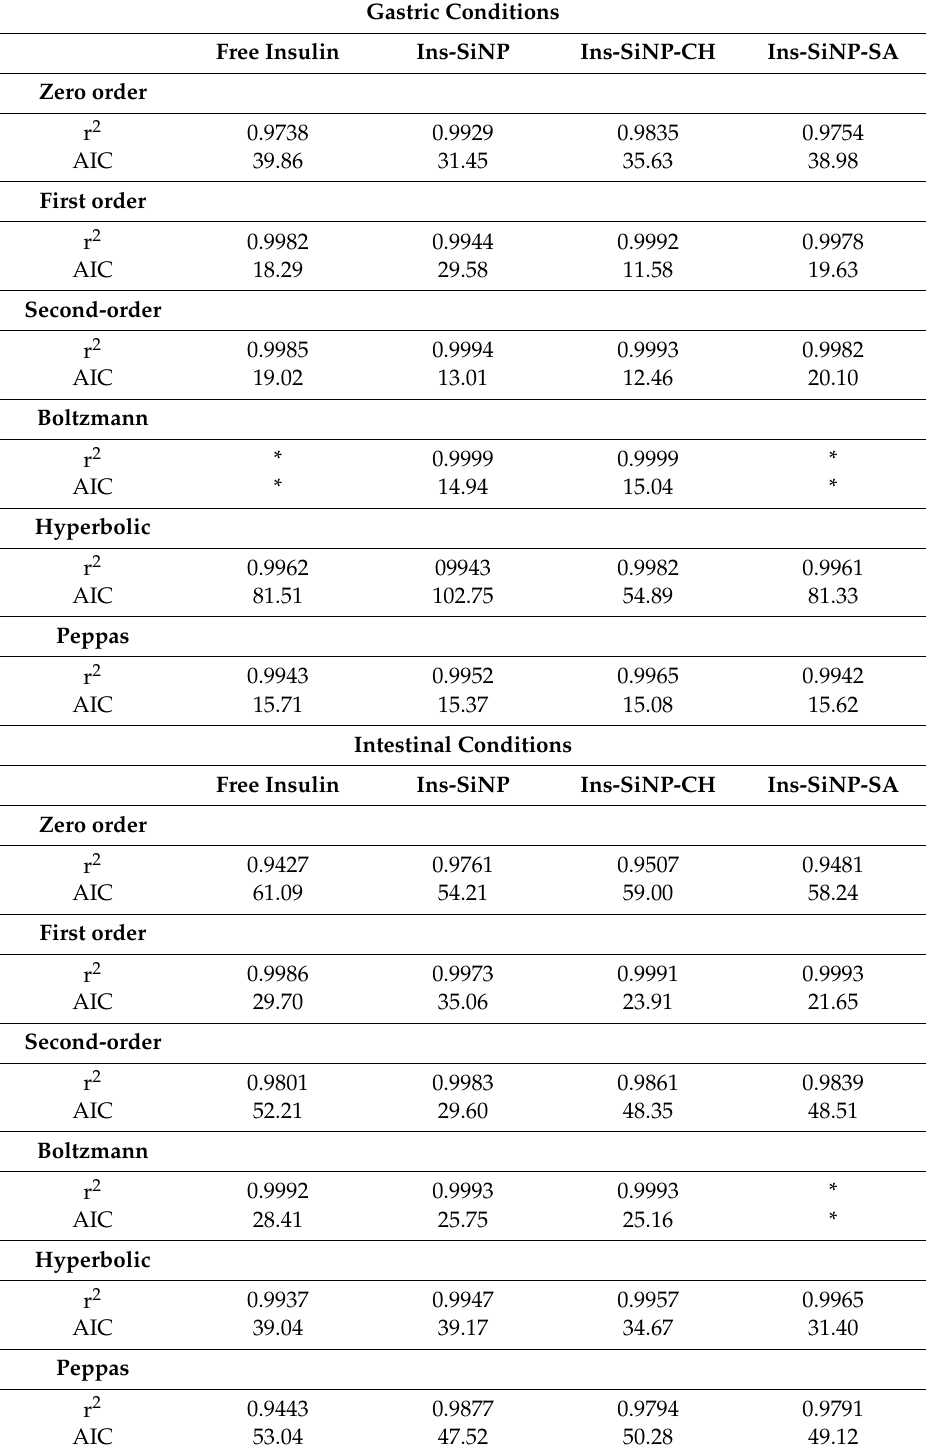
Table 5. Comparative study of insulin release kinetics from uncoated and coated SiNP at gastric and intestinal